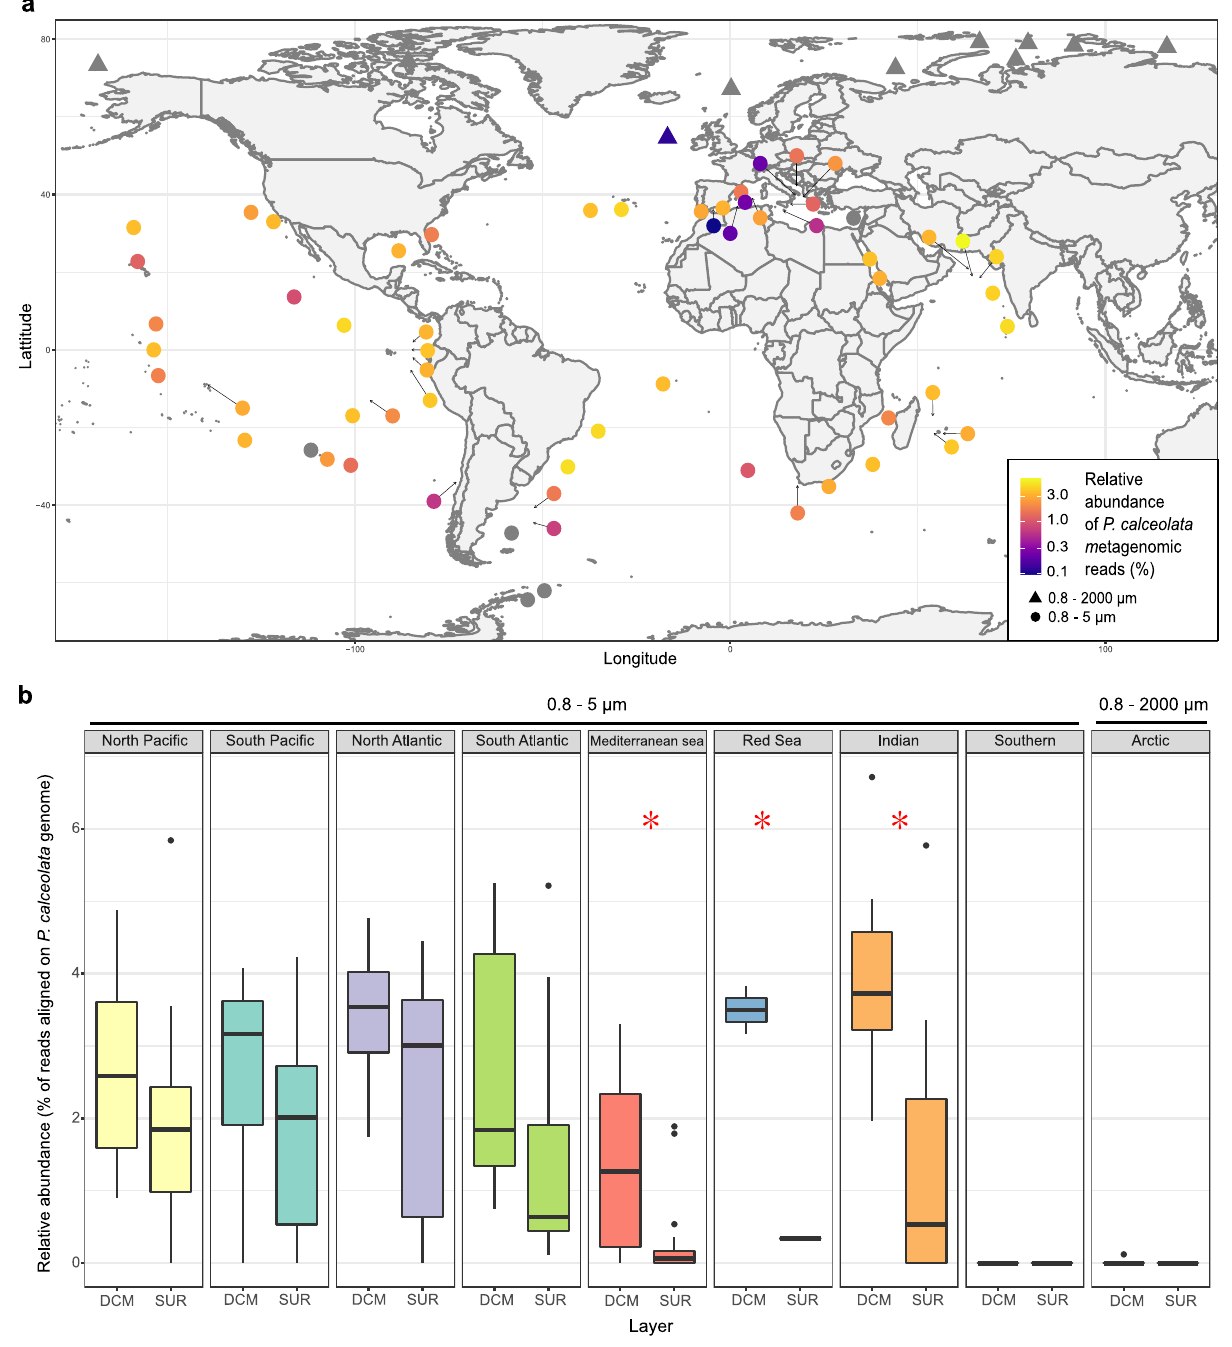
Fig. 2 Relative abundance and distribution of P. calceolata in the oceans. a World map of the relative abundance of P. calceolata metagenomic reads. The color code indicates the percentage of sequenced reads aligned on the genome. The DCM samples of size fractions 0.8 – 5 µ m (circles) or 0.8 – 2000 µ m (triangles) are shown. P. calceolata is considered to be absent when the horizontal coverage is below 25% of the genome (gray dots). b Boxplot of the relative abundance in each oceanic region in surface and DCM samples. Red stars indicate a signi fi cant difference between SUR and DCM samples (Wilcoxon test, P value